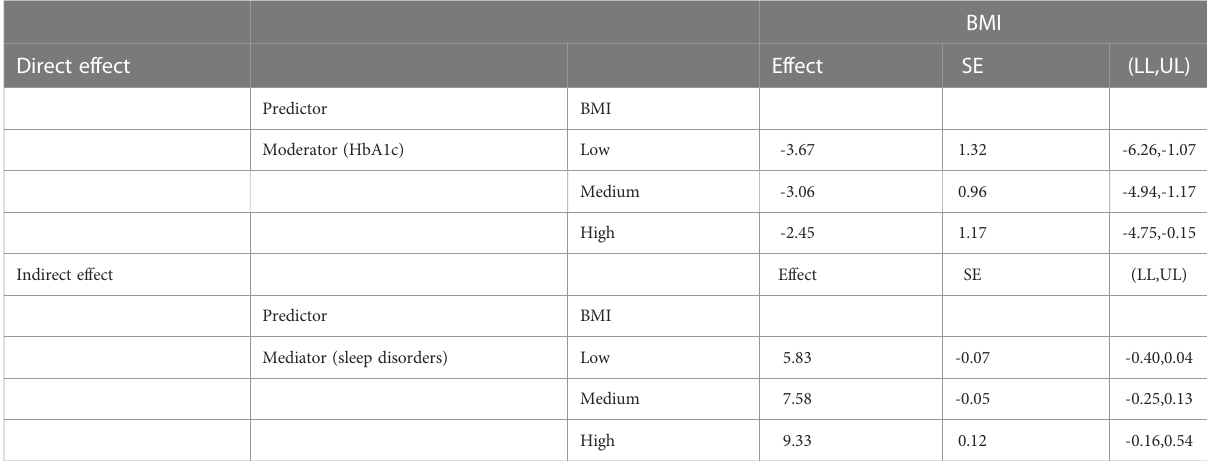
TABLE 10 Bootstrapped conditional direct and indirect effects.